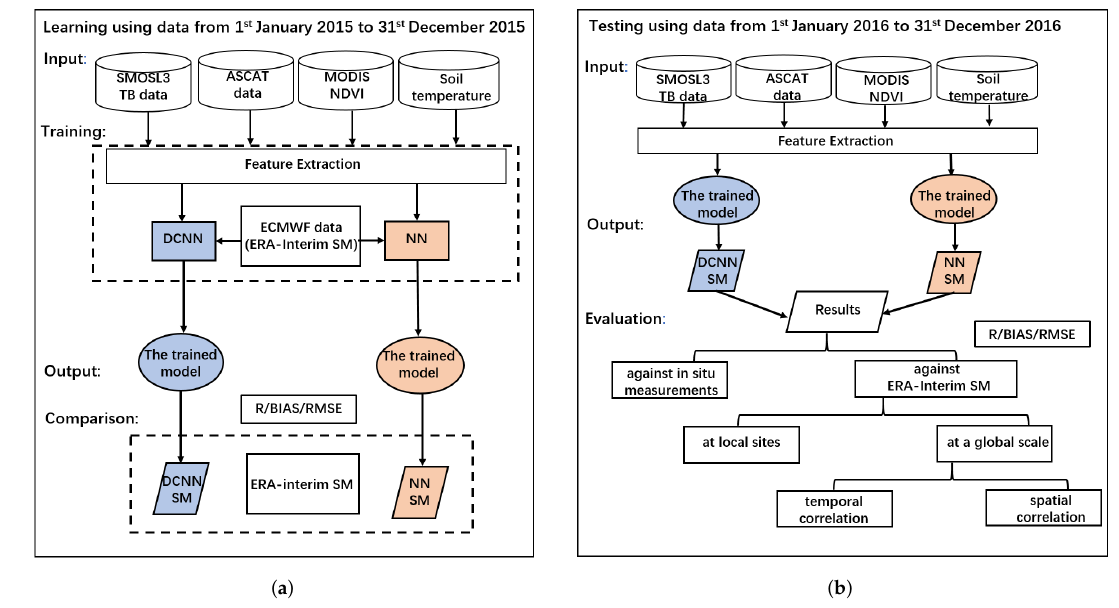
Figure 3. Flow chart of experiments. ( a ) learning phase; ( b ) testing